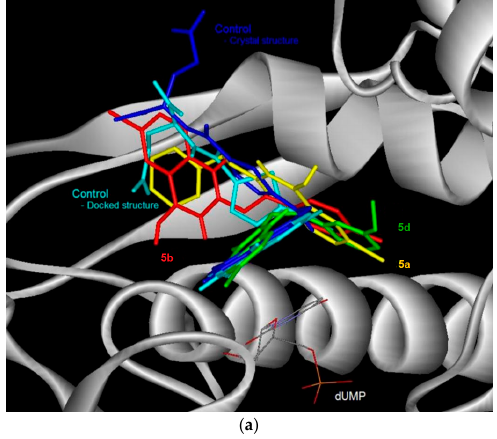
Figure 3. Cont. Figure 3. Cont.